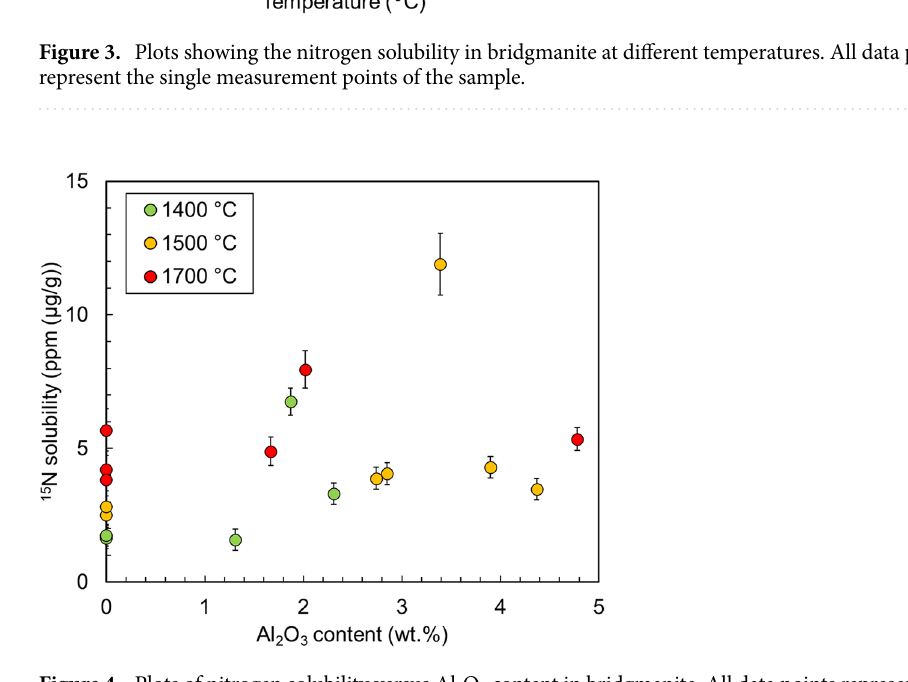
Figure 4. Plots of nitrogen solubility versus Al 2 O 3 content in bridgmanite. All data points represent the single measurement points of the samples. The nitrogen solubilities in Al- and Fe-bearing bridgmanite are not shown